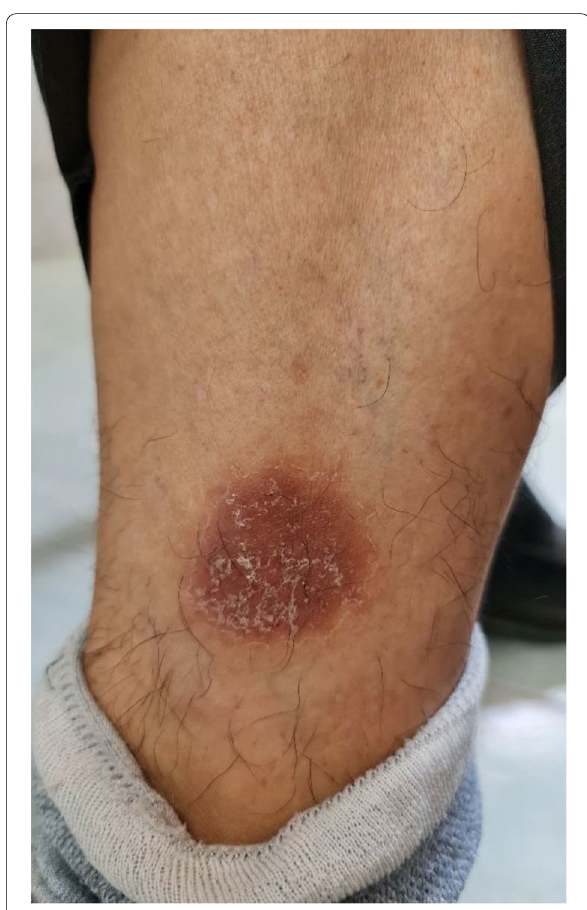
Fig. 3 Psoriasis vulgaris. Well-defined red-brown scaly plaque on the lateral aspect of right shin consistent with psoriasis vulgaris. Image 3 was obtained via Samsung Galaxy Note ultra 5G cellphone